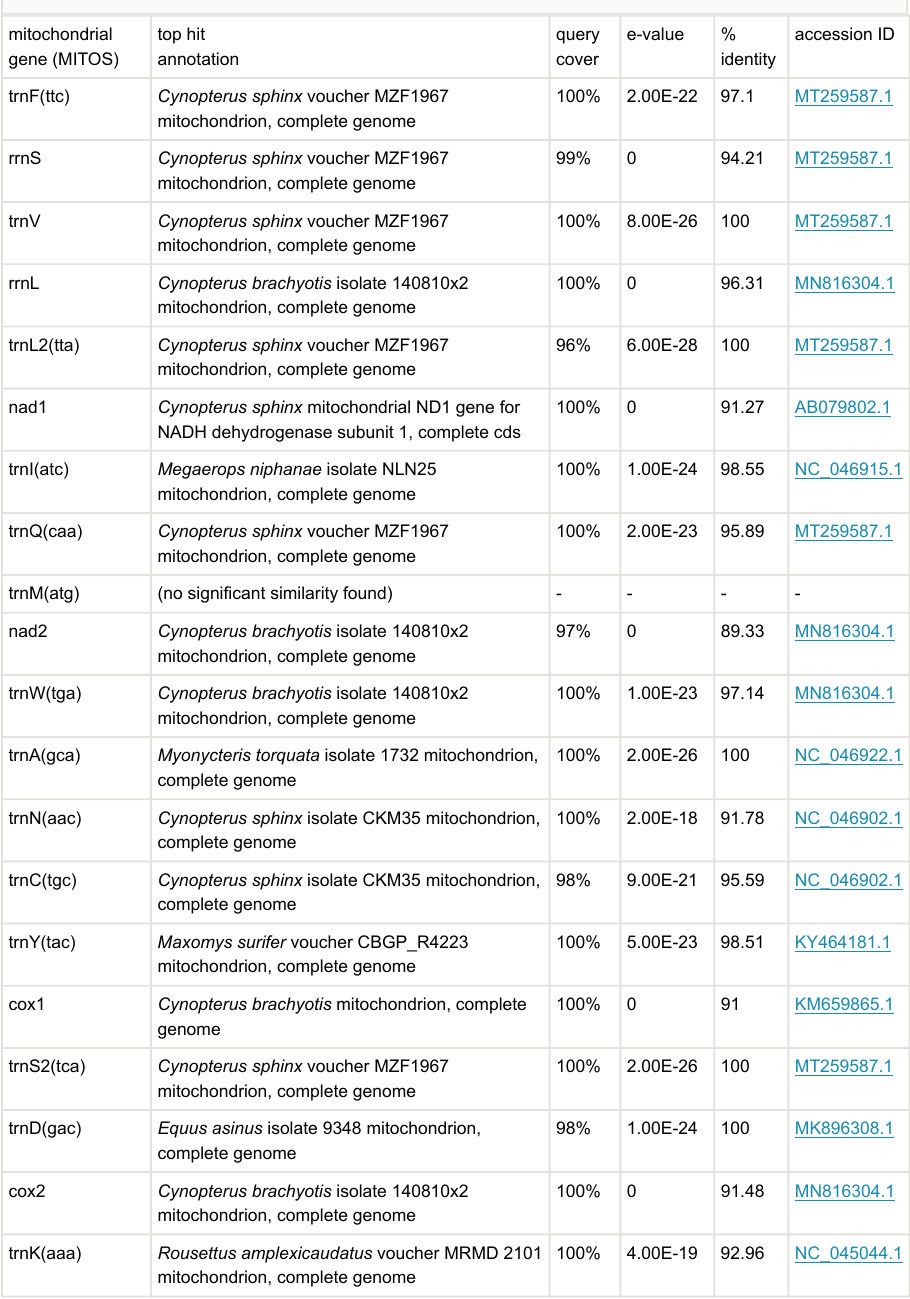
Top NCBI-BLAST hits for the MITOS-annotated mitochondrial